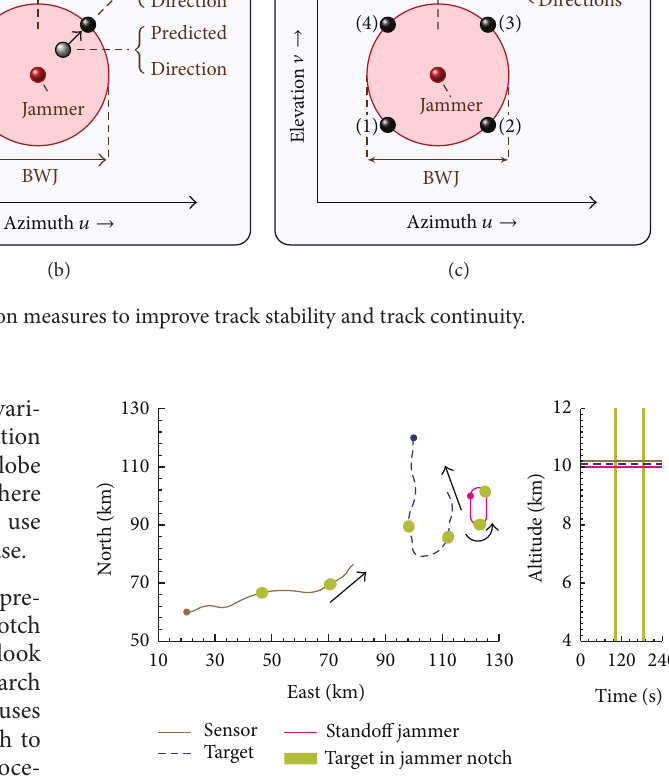
Figure 19: Target tracking scenario with standoff jammer: geo- graphic plot of platform